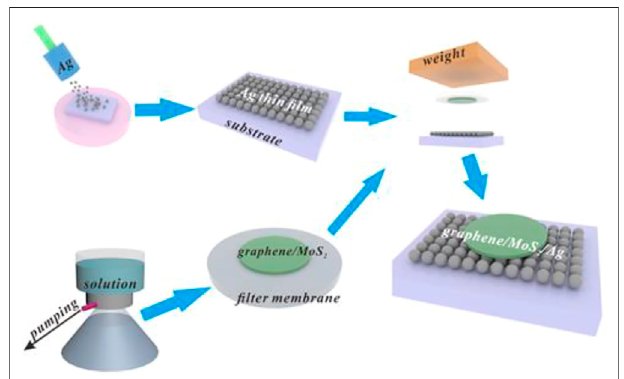
FIGURE 1 | Graphene/MoS 2 /Ag thin fi lm preparation process and structure